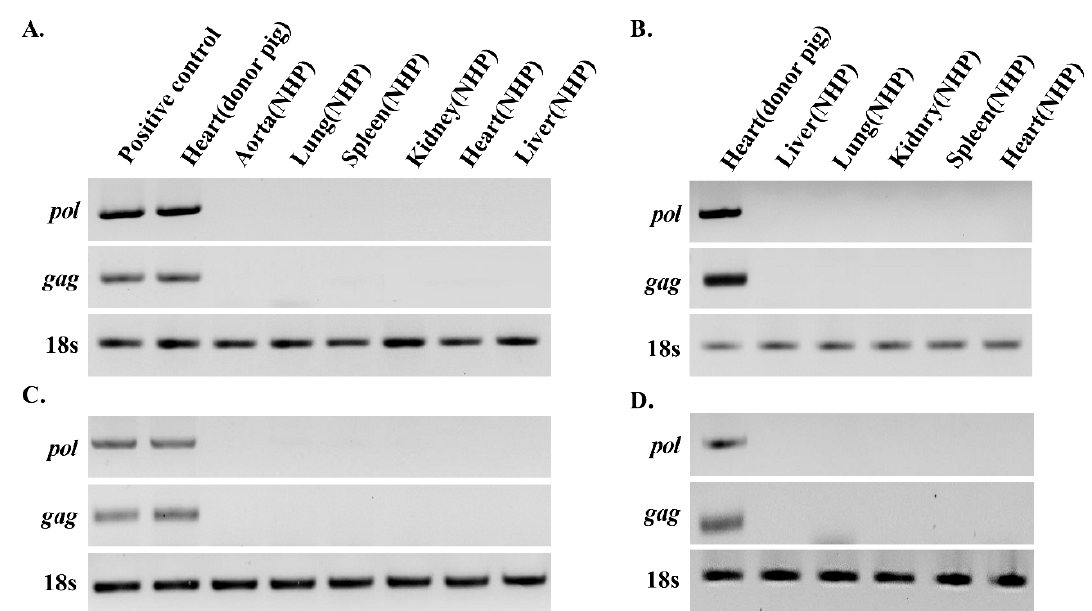
Figure 1. Analysis of PERV in different tissues of the heart transplanted recipients by PCR. The PCR and RT-PCR were performed to detect PERV gag and pol in different of heart transplanted recipients. The PERV level identified via electrophoresis and normalized to that of 18s rRNA. ( A ) gDNA and ( C ) cDNA of the heart transplanted recipients NHP 23-16. ( B ) gDNA and ( D ) cDNA of the heart transplanted recipients NHP 20-01.